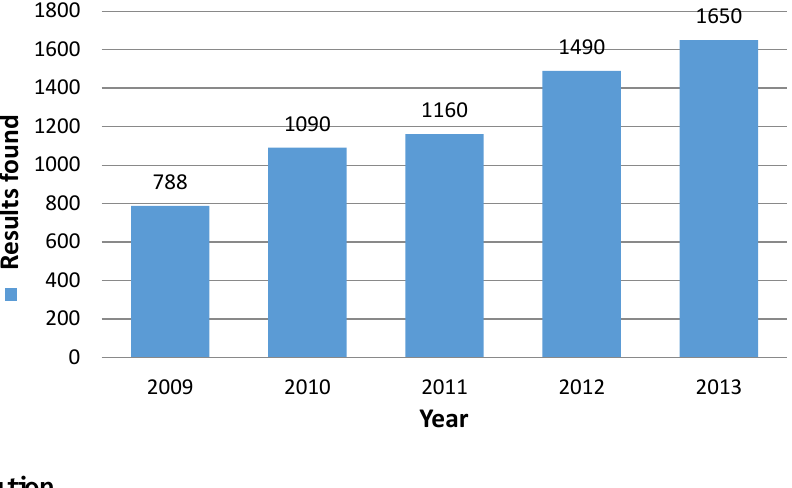
Figure 8. Number of results for a “prosumer business” Academic Google